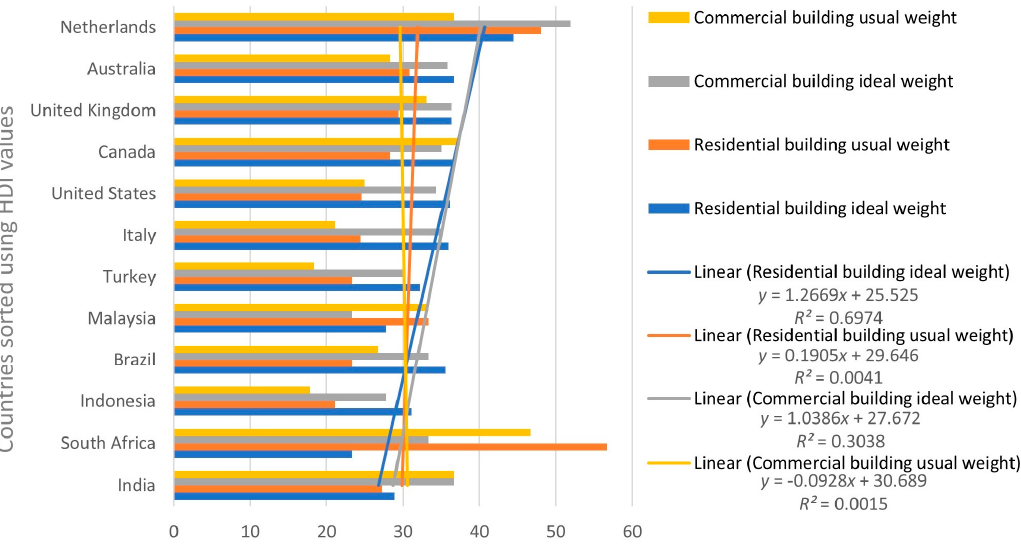
Figure 6. Environmental sustainability weights for different countries sorted by HDI value.